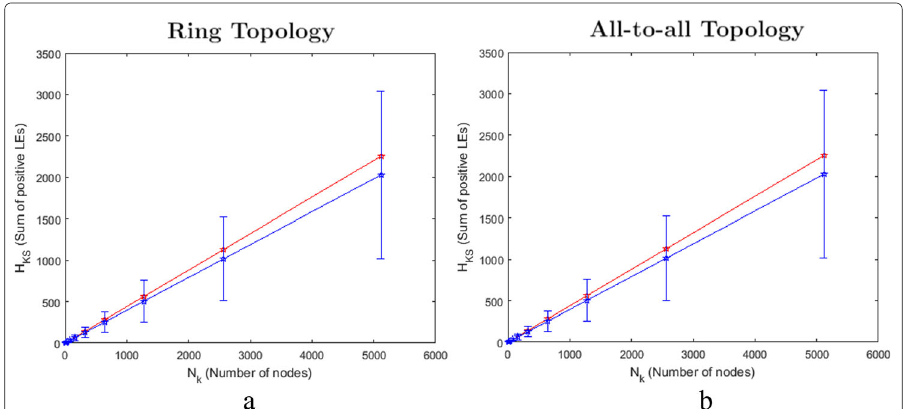
Fig.3 The sum of positive LEs with respect to the number of nodes for networks satisfying case 2 with ( a ) ring and ( b ) all-to-all topology. For each network we considered the building block with N 0 = 5 and ε = 2 · 10 − 4 . The inter-coupling of the network (cid:2) ( 1 ) is γ( 1 ) = 0.5045 and k = [1,2, ... ,10]. In ( a ), the linear fitting in the blue line has p 1 = 0.3965 and p 2 = − 0.9896, and the one in the red line has p 1 = 0.4407 and p 2 = − 0.9422. In ( b ), the linear fitting in the blue line has p 1 = 0.3962 and p 2 = − 0.9881, and the one in the red line has p 1 = 0.4405 and p 2 = − 0.9412, where p 1 is the slope and p 2 is the constant coefficient of the